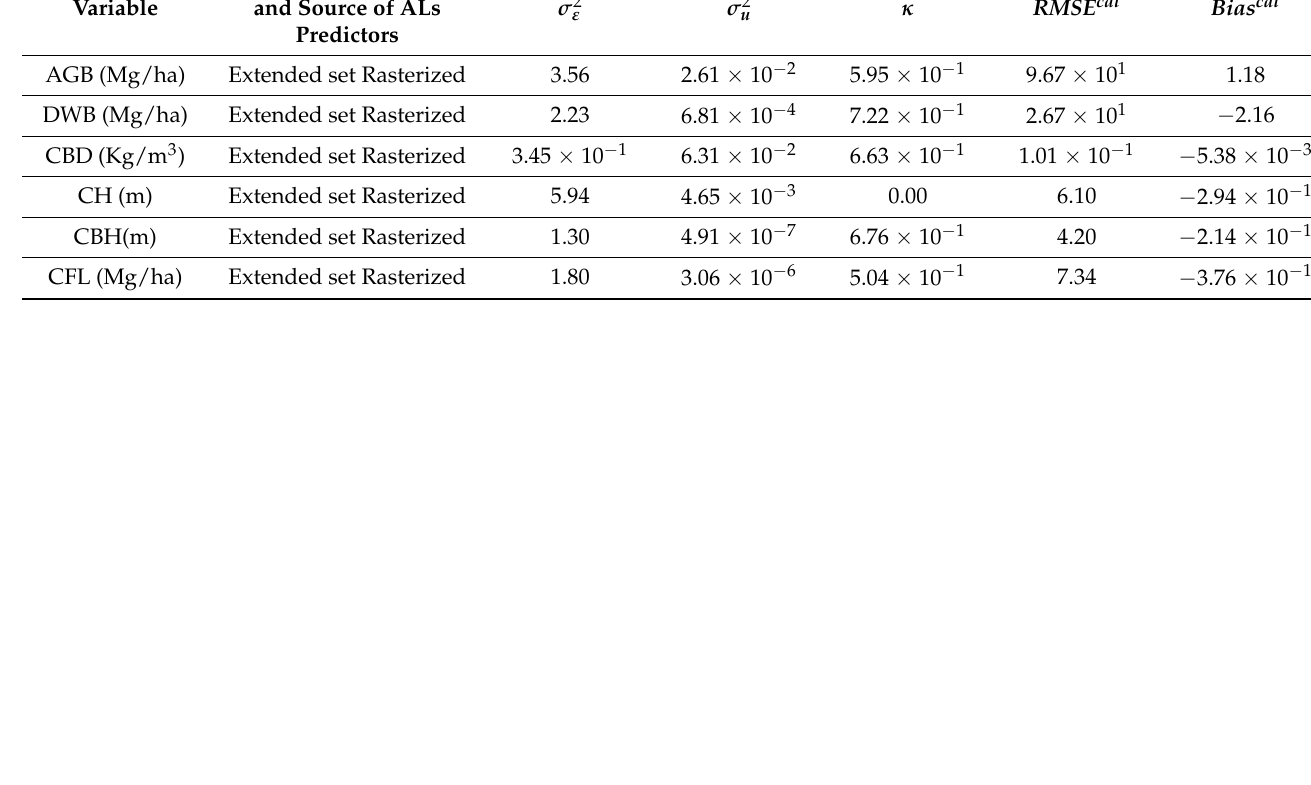
Figure A6. Predictors included in the semiparametric models and variable importance as percent reduction in mean squared error for the extended set of 20 ALS acquisitions using rasterized predictors described in Appendix A. Model response variables are: aboveground biomass (AGB), downed woody biomass (DWB), canopy bulk density (CBD), canopy height (CH), canopy base height (CBH), and canopy fuel loading (CFL). Table A8. Variance parameters for the random effects and model errors for the semiparametric models obtained for each response variable for the extended set of 20 ALS acquisitions using rasterized predictors described in Appendix A. Model response variables are: aboveground biomass (AGB), downed woody biomass (DWB), canopy bulk density (CBD), canopy height (CH), canopy base height (CBH), and canopy fuel loading (CFL).